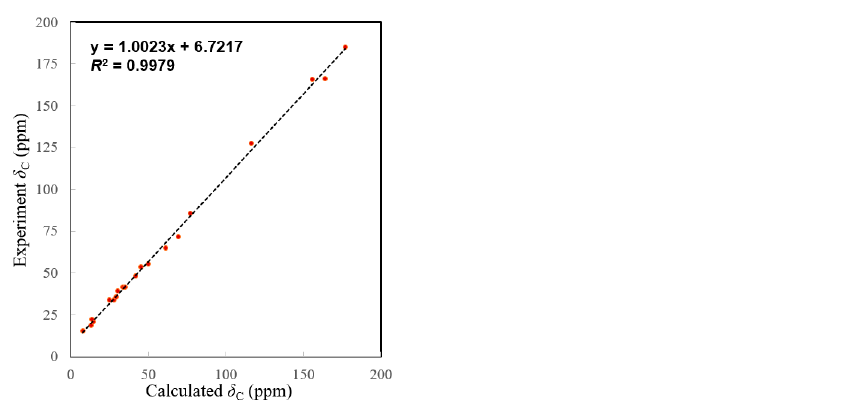
Figure 6. Linear correlation plots of predicted versus experimental 13 C NMR chemical shifts. The other two known diterpenoids ( 3 – 4 ) were identified to be ent -abietane diter- penoids raserranes A ( 3 ) and B ( 4 ) by comparison of their NMR data with those reported in the literature, these four diterpenoids were discovered for the first time from this species